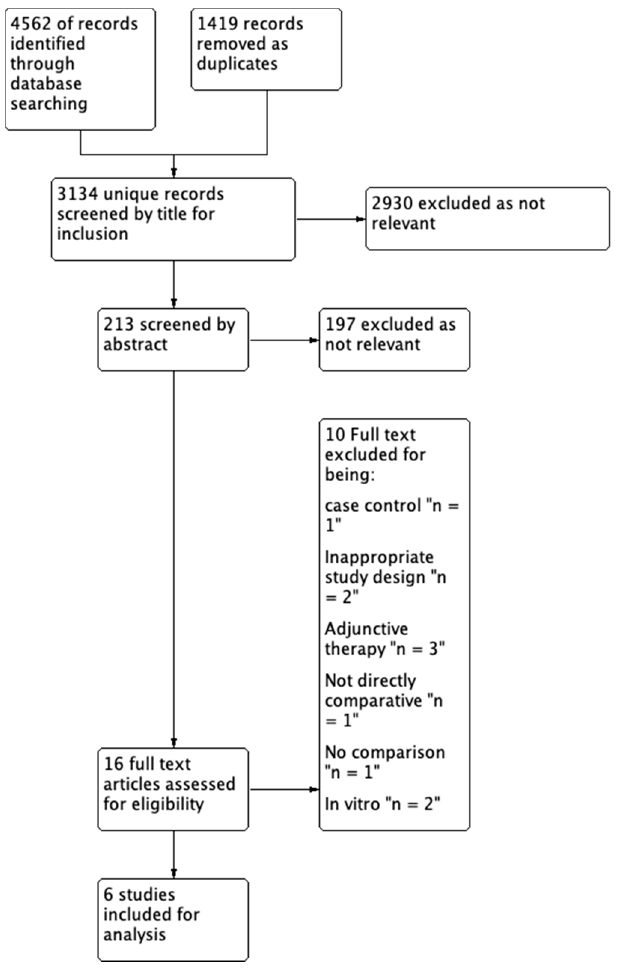
Figure 1. PRISMA flow chart.